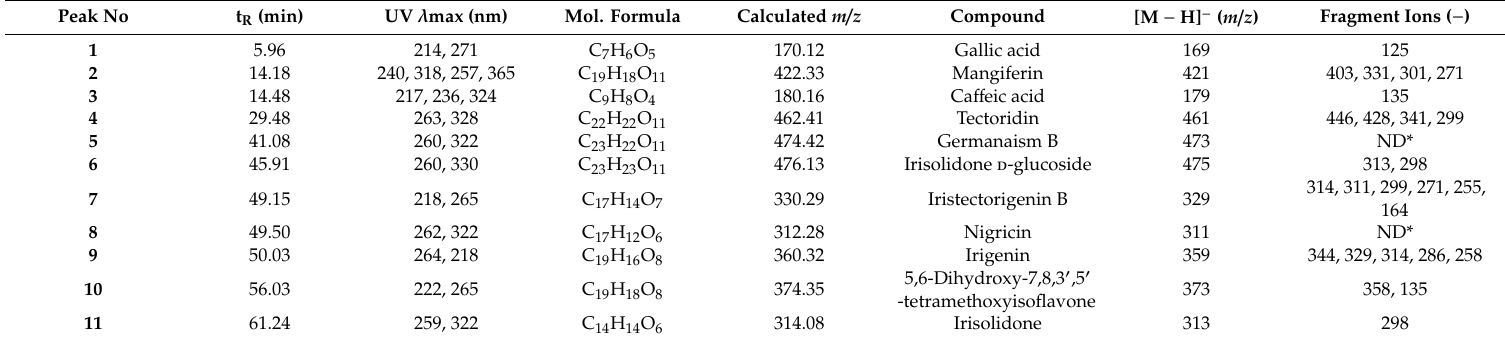
Table 3. Chromatographic, UV, and mass spectroscopic data of the reference